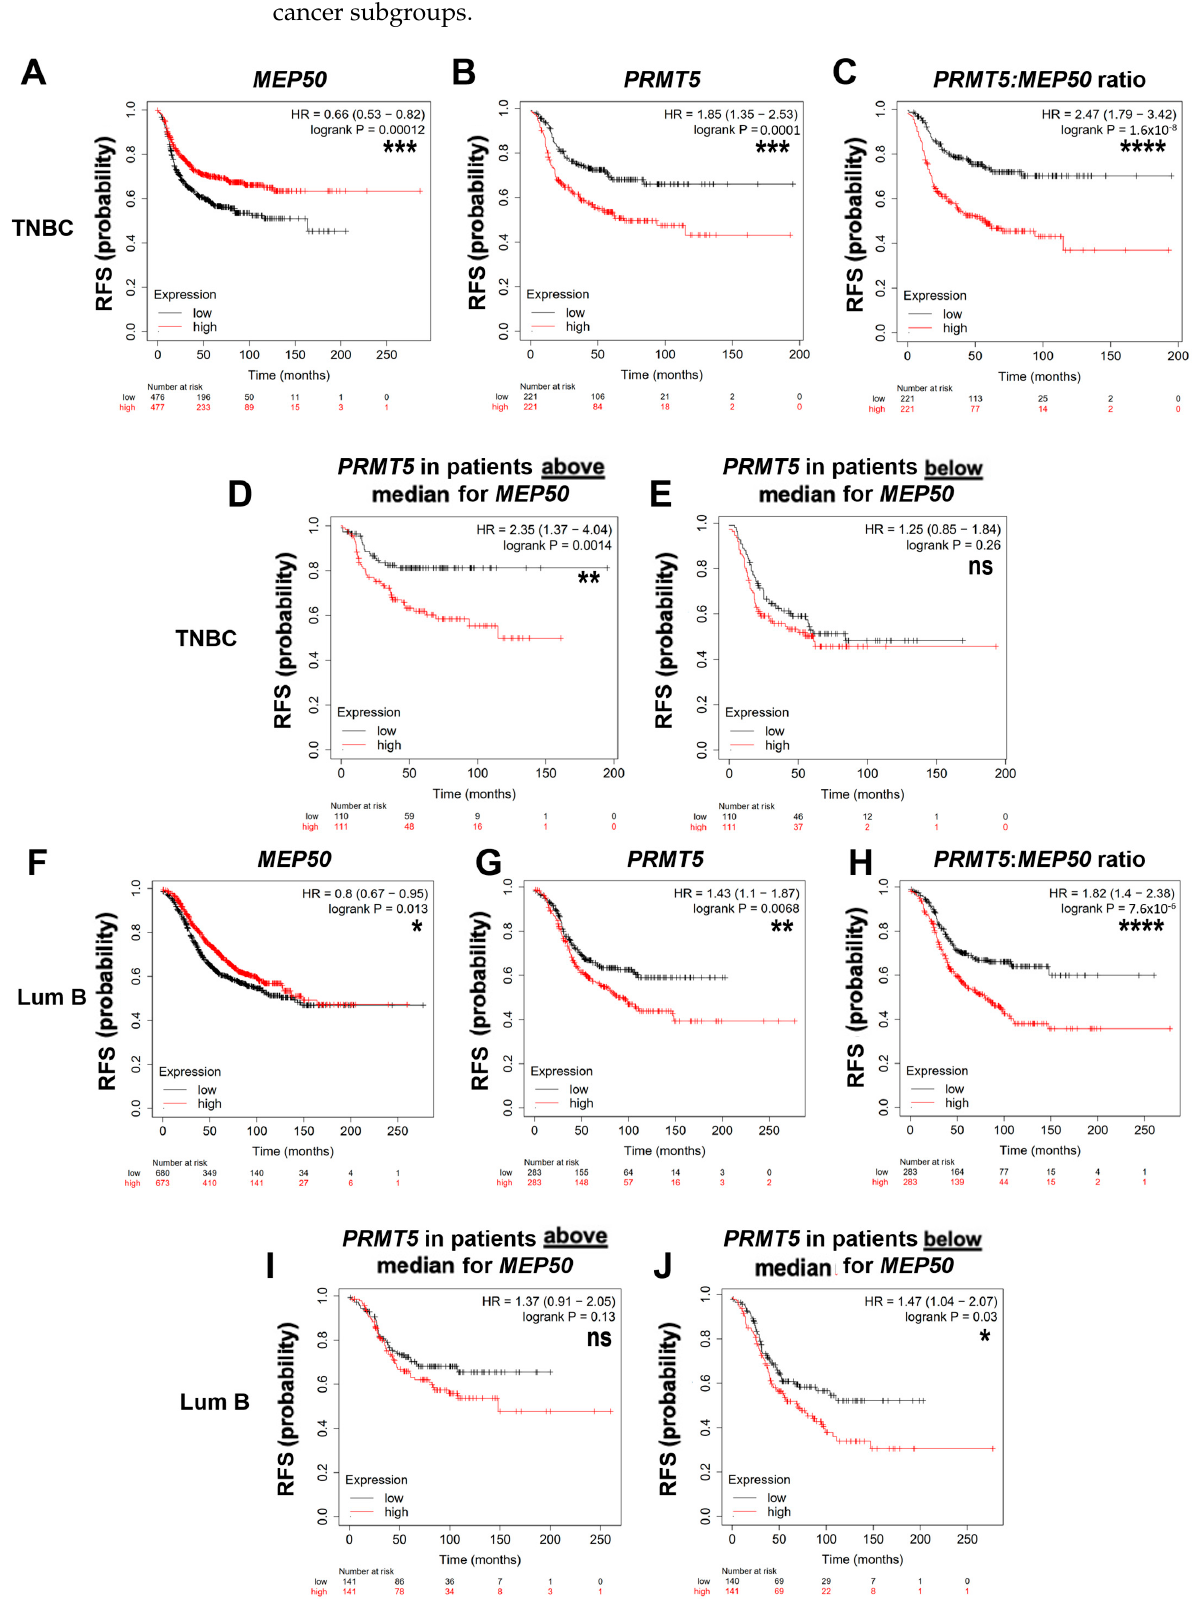
Figure 2. High MEP50 mRNA expression is associated with a better prognosis in TNBC and luminal